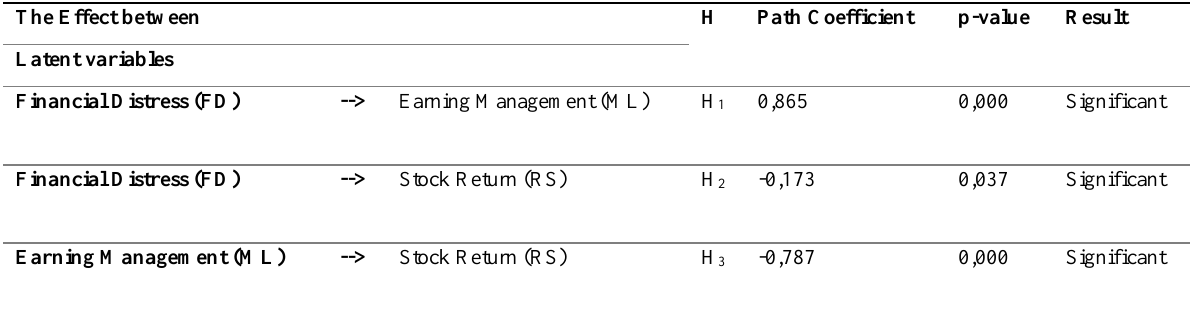
Table 2: Model 2 (Springate) Hypothesis Test